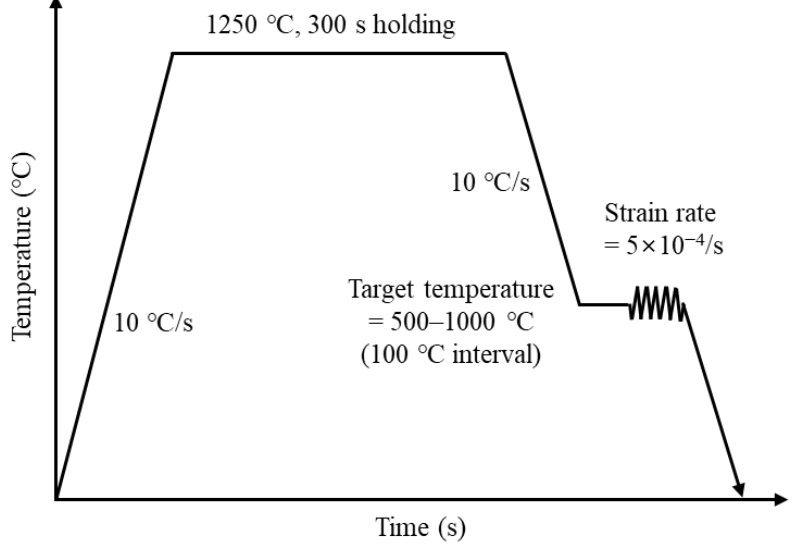
Figure 1. Schematic illustration of thermal history for hot ductility test. Table 1. Chemical composition (wt.%) of high-Mn steels for hot ductility test. Code